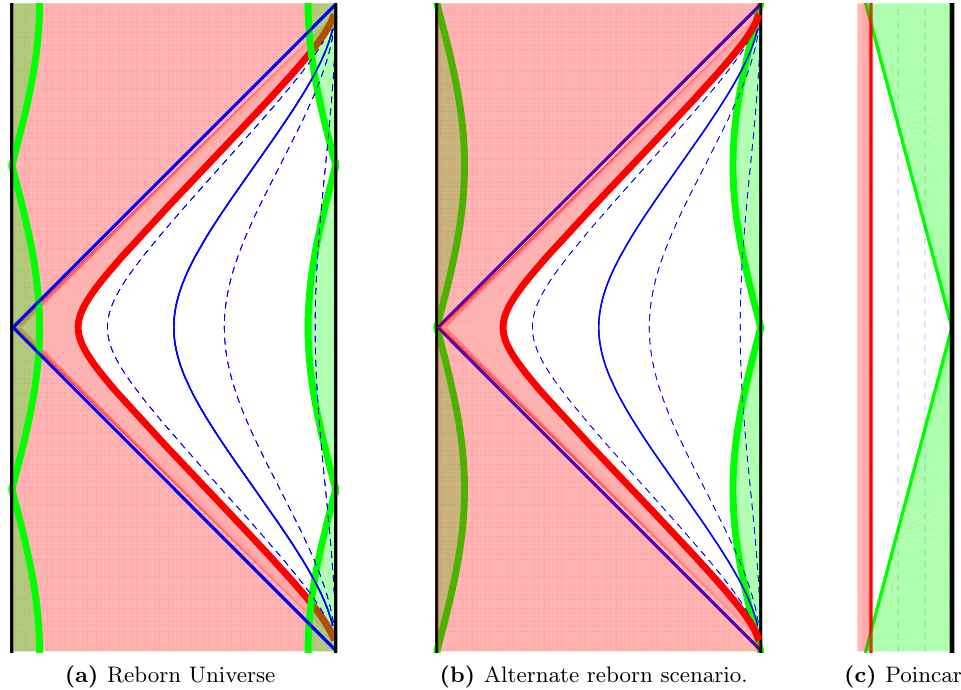
Figure 8. Reborn Universes. Unlike other embeddings displayed in this work, panel c) is not showing a cross section of global AdS, but instead is displaying the same branes as panel b) but using standard Poincare Patch